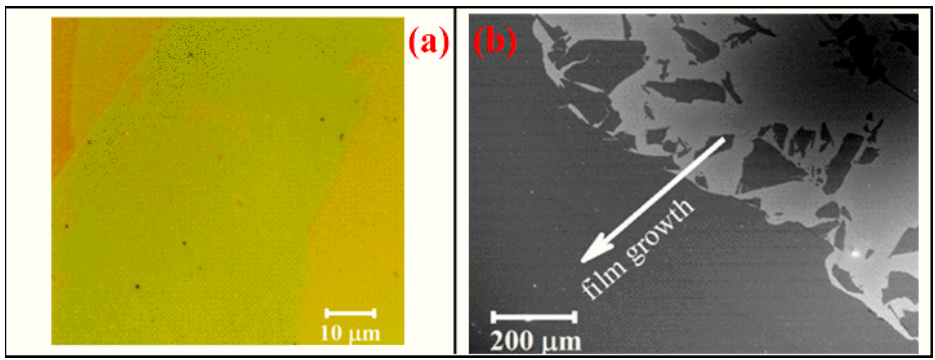
Figure 2. Optical ( a ) and SEM ( b ) images of the reduced graphene oxide (rGO)–PbS LB film.